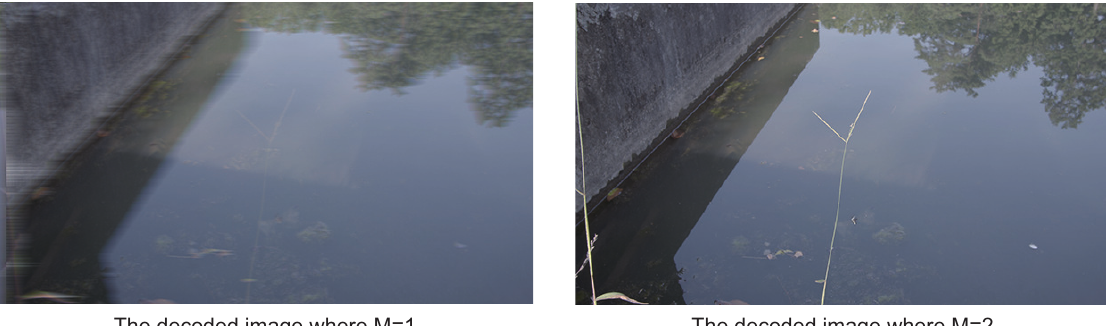
The decoded image where M=1 The decoded image where M=2 Figure 8. The decoded images when M = 1 and M = 2 using the evaluation image b) shown in Figure